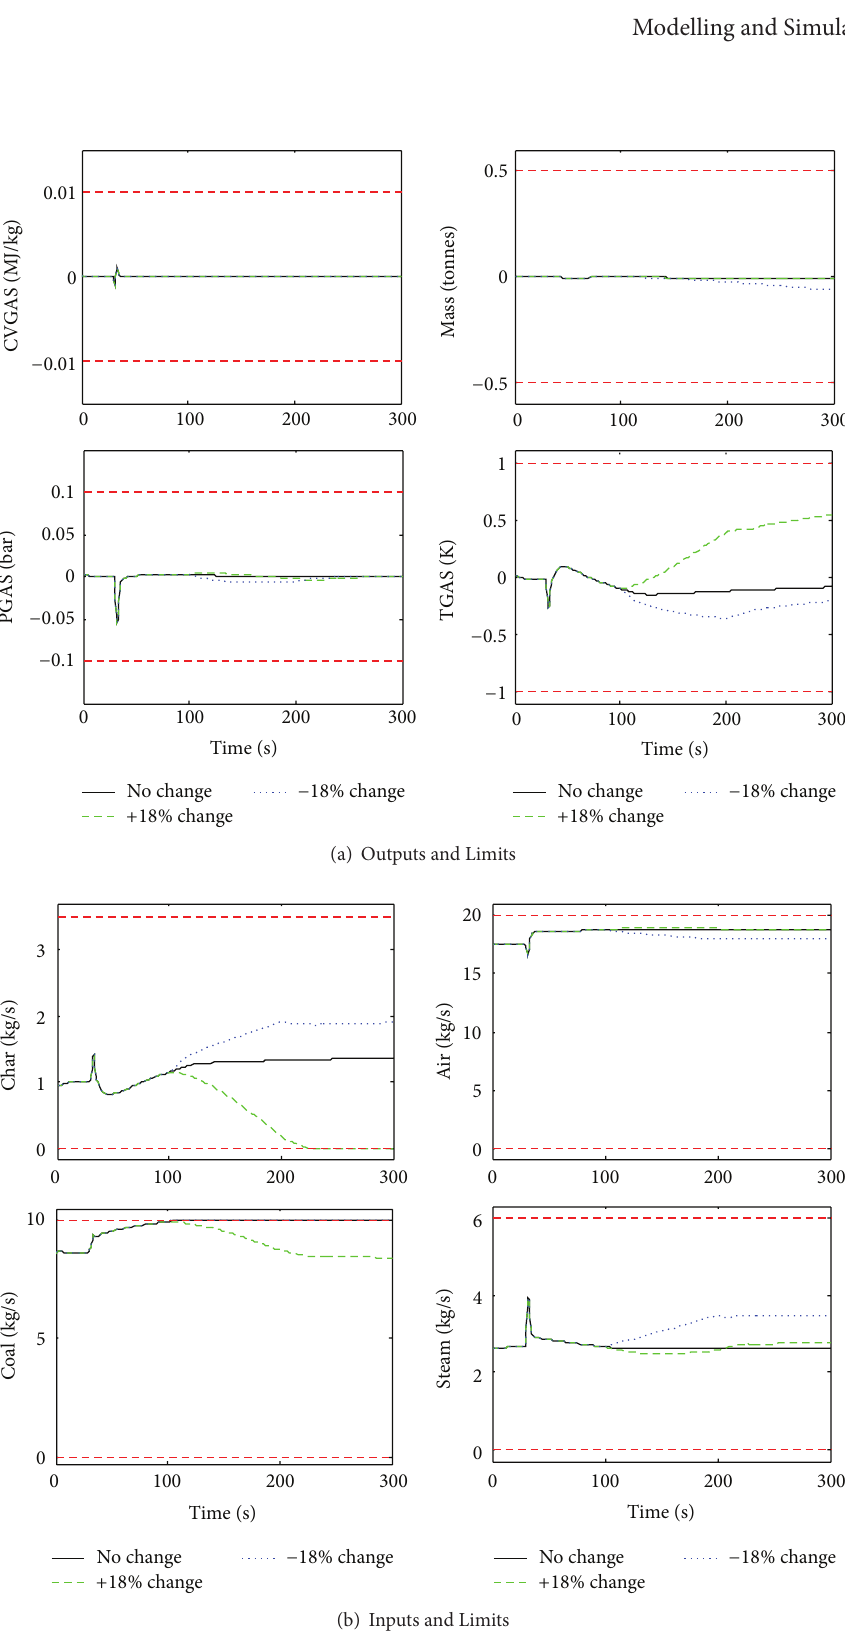
Figure 11: Response to step disturbance at 100%